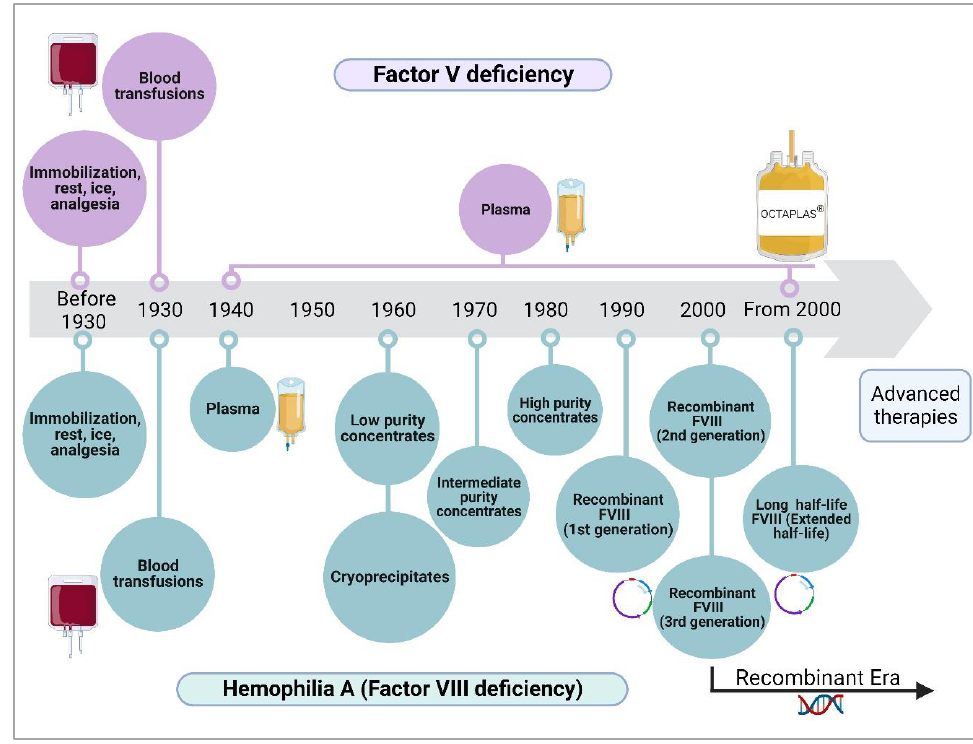
Figure 3. Evolution of the various strategies for the treatment of factor V deficiency and hemophilia A (Factor VIII deficiency).